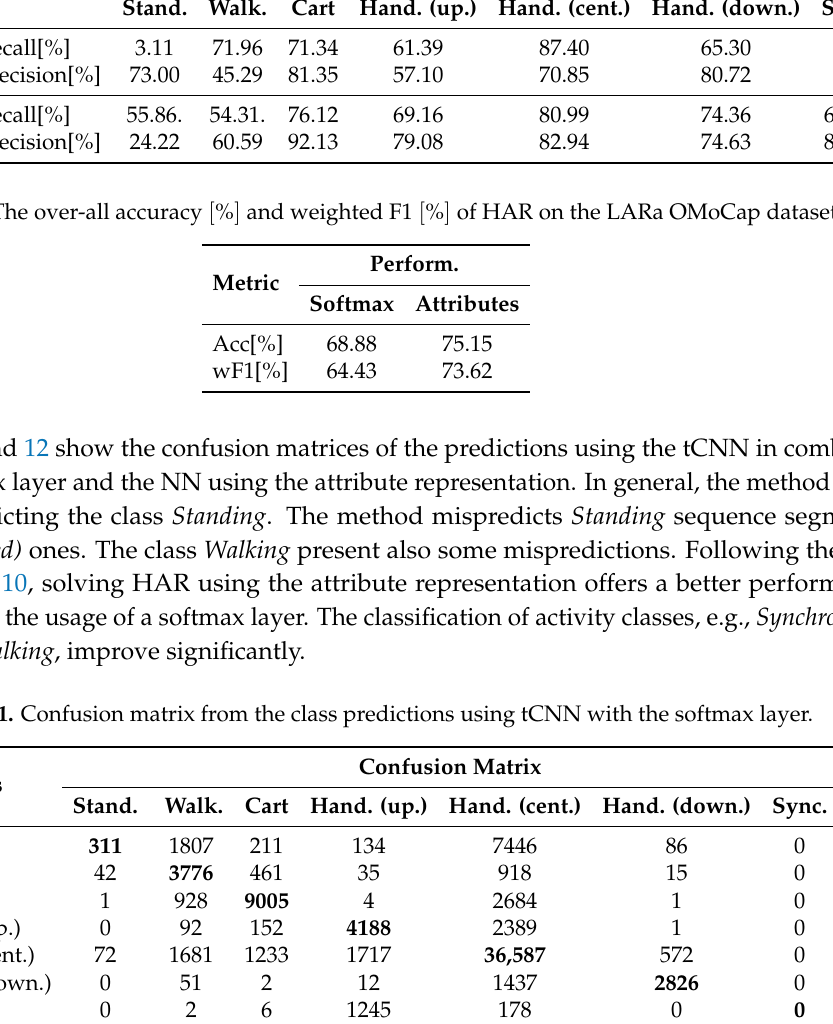
Table 12. Confusion matrix from the class predictions using the attribute predictions with tCNN and the nearest neighbor (NN) approach.